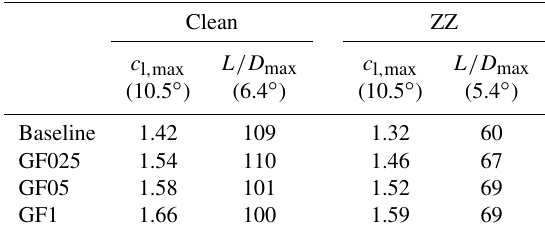
Table 6. NACA63(3)618. Gurney flaps. Characteristic